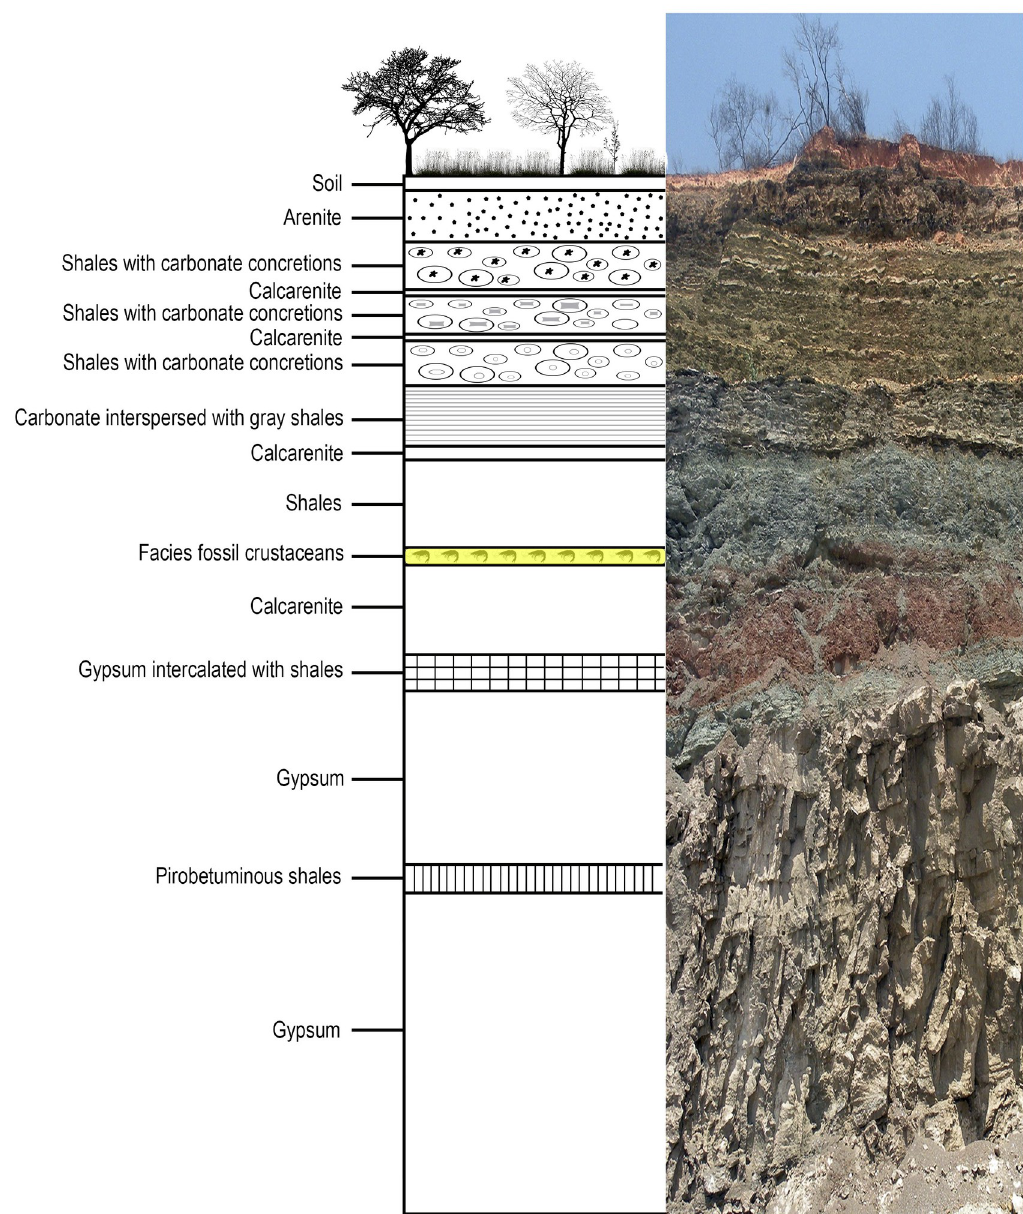
Fig 1. Stratigraphic profile and scheme of the Romualdo Formation. Stratigraphic profile and scheme of the Romualdo Formation (Cretaceous—Aptian/Albian) where the specimens were collected. Vertical exposure = 32 m. figure from 2B were obtained from Brazilian Geological Service (CPRM, at https://geoportal. cprm.gov.br/geosgb/) powered by ESRI.